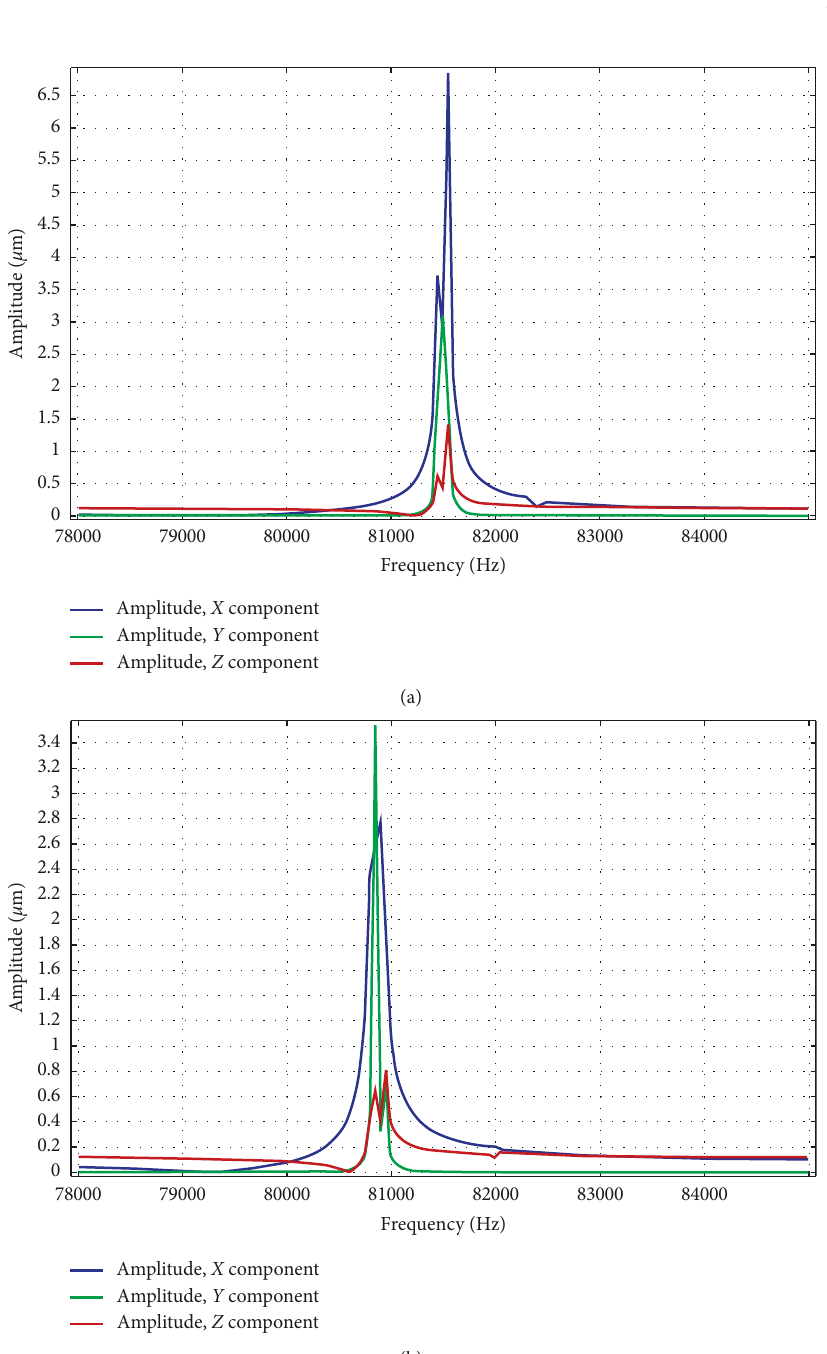
Figure 3: Amplitude-frequency characteristic of the contact points vibrations when the single electrode of the upper cylinder (a) and lower cylinder (b) is